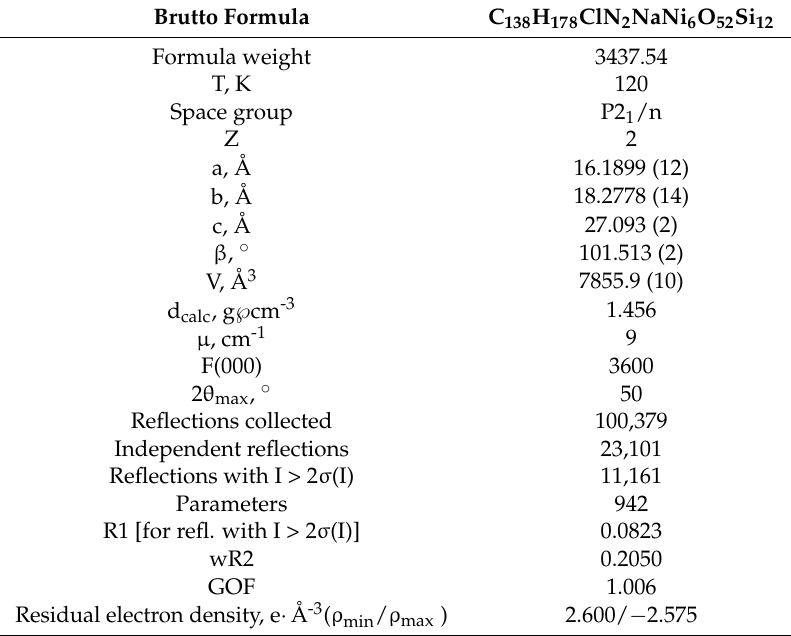
Table 2. Crystal data and experimental parameters of the